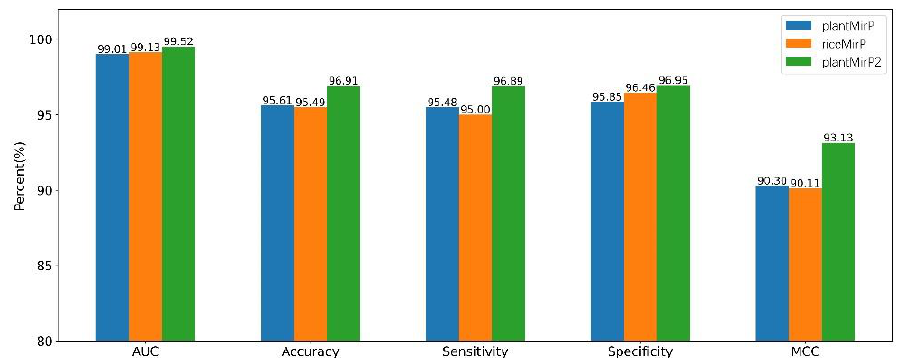
Figure 7. Based on the miRbase (release 21) training dataset and the miRbase (release 22.1) testing dataset, indicators of plantMirP, riceMirP and plantMirP2 were compared.